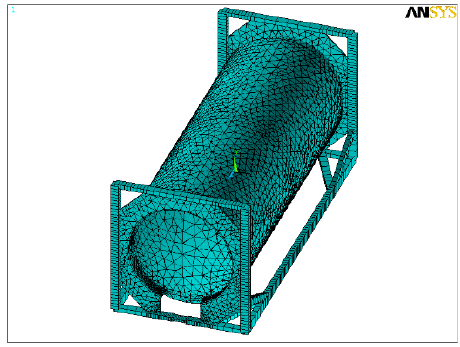
Figure 2. Mesh of the considered model.